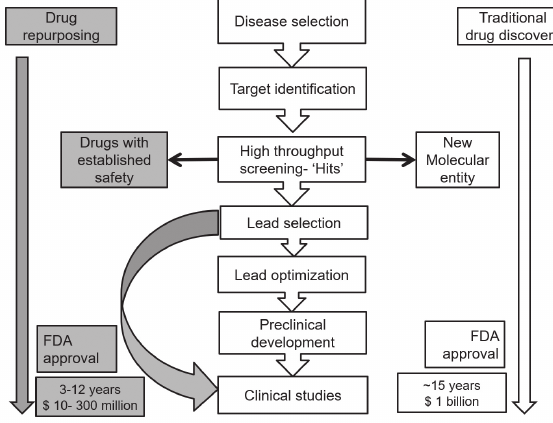
Figure 1. Drug repurposing concept in drug development.